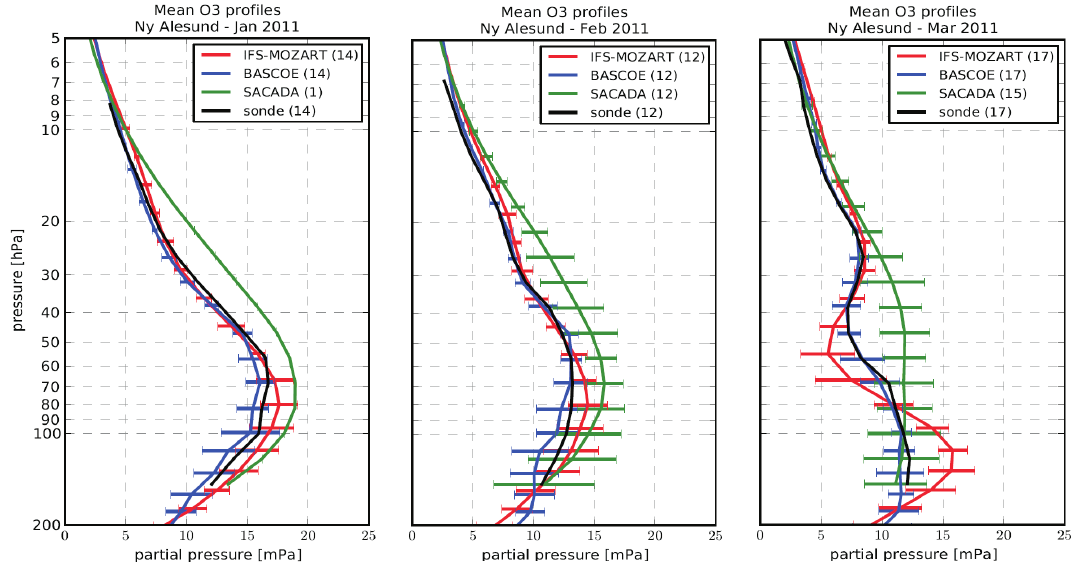
Figure 10. Comparison of the monthly averaged O 3 partial pressures, in mPa, by IFS-MOZART (red), BASCOE (blue) and SACADA (green) with O 3 sonde profiles observed at Ny-Ålesund for January to April 2011. The number of available O 3 sonde profiles and the number of collocated system profiles are indicated in